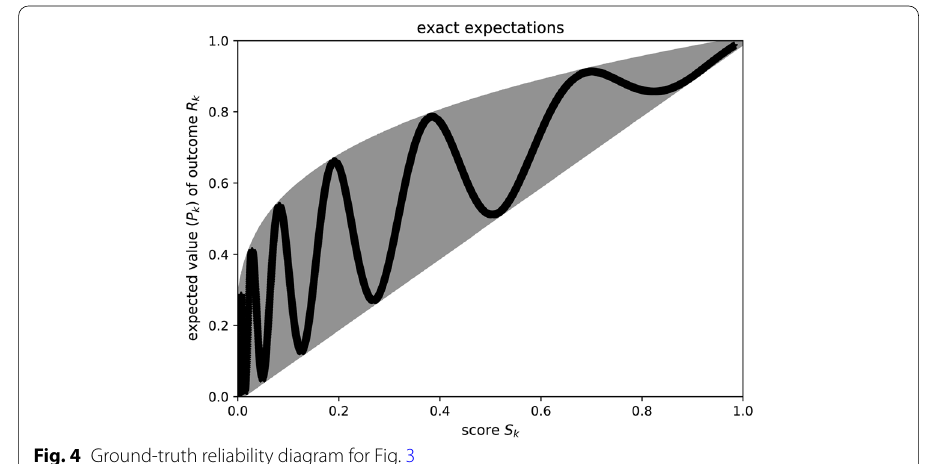
Fig. 4 Ground-truth reliability diagram for Fig.